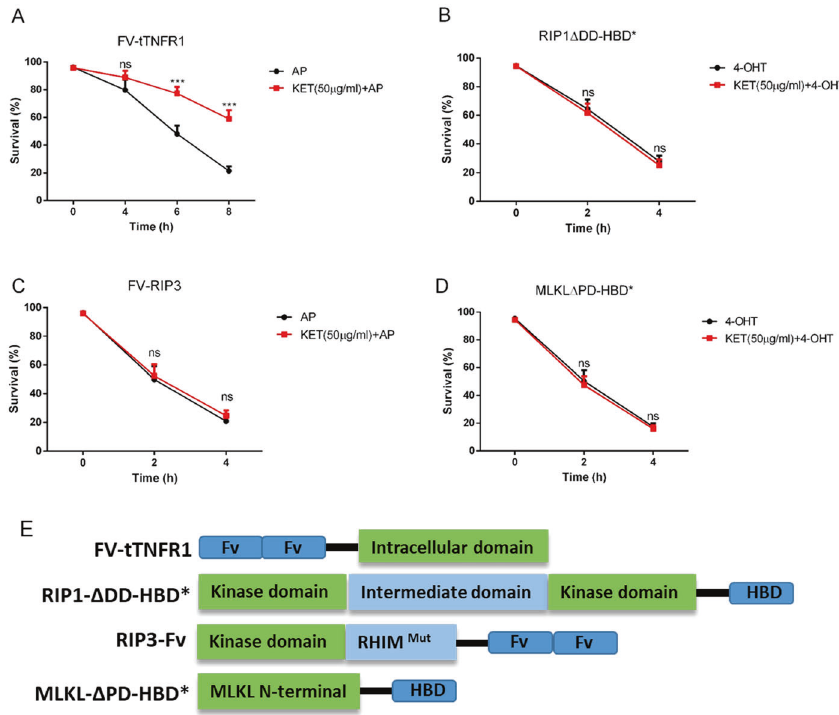
Fig. 7 Ketamine targeted RIP1 or factors upstream of RIP1 in TNF- α TNF- α -induced L929 cell necroptosis. A – D Lentivirus expressing proteins described in E was used to infect corresponding KO L929 cells. These cells were treated with 4-OHT for the HBD*-fused protein and AP20187 for the FV-fused protein at the indicated times with or without ketamine. Cell death was analyzed by fl ow cytometry, and the quantitative data are the mean values of three independent experiments. The error bars are the mean ± SEM., *** p < 0.001, ns: no signi fi cant difference. E Schematic illustration of FV-fused tTNFR1, RIP3, and HBD*-fused RIP1 Δ DD; MLKL Δ PD; HBD* represents the HBD-G521R mutation; RHIM mut represents the QIG449-451AAA